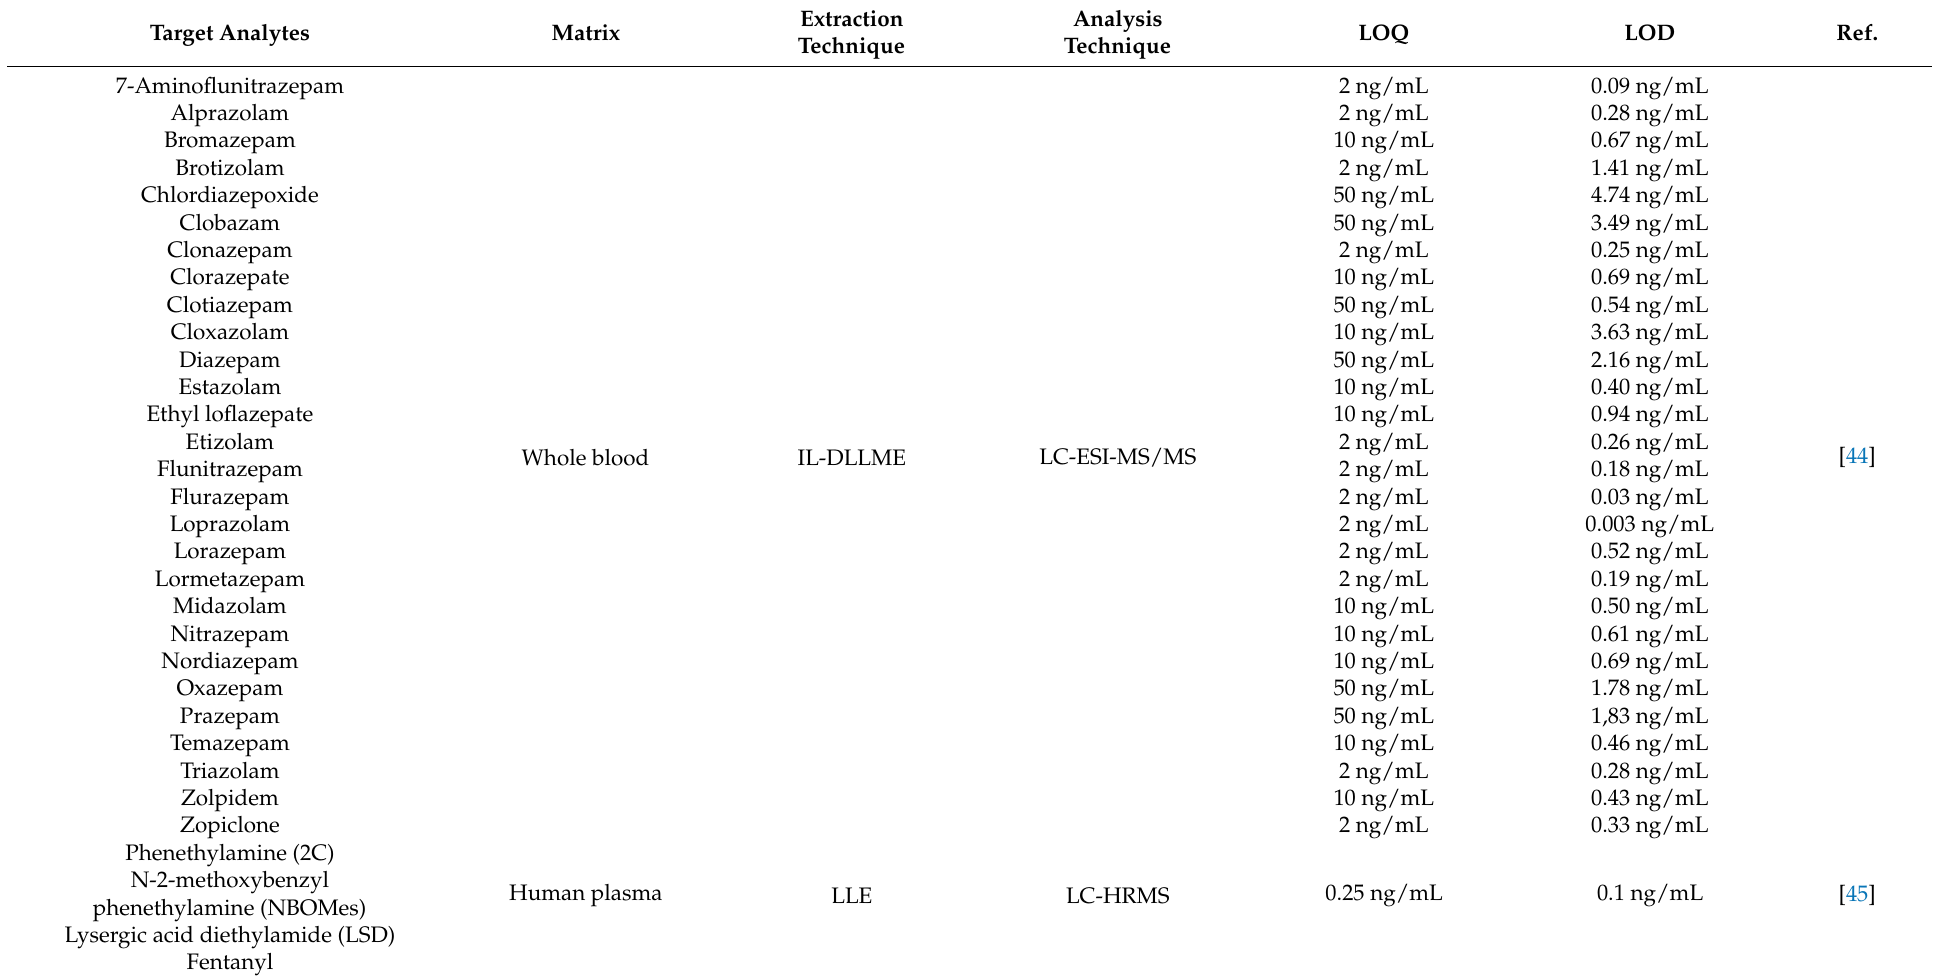
Table 1. Microextraction techniques used in the forensic and biological